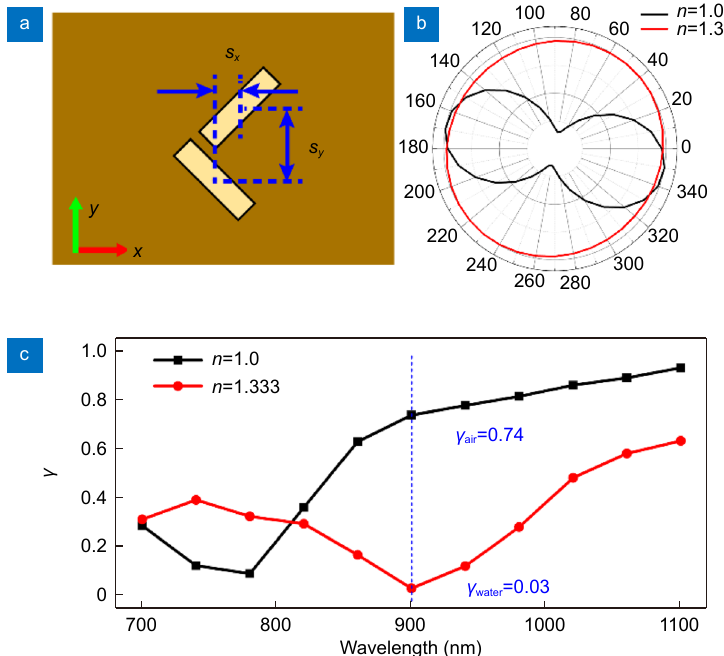
Fig. 3 | ( a ) Structure diagram and geometry parameters of the plasmonic emitter. ( b ) Polar plot of the simulated intensity of the emission light from the plasmonic emitter as a function of the polarization angle for n =1.333 (red line) or n =1.0 (black line) at λ =900 nm. ( c ) Degrees of linear polarization of the emission light from the plasmonic emitter varying with the wavelengths for n =1.333 (red line) or n =1.0 (black line).